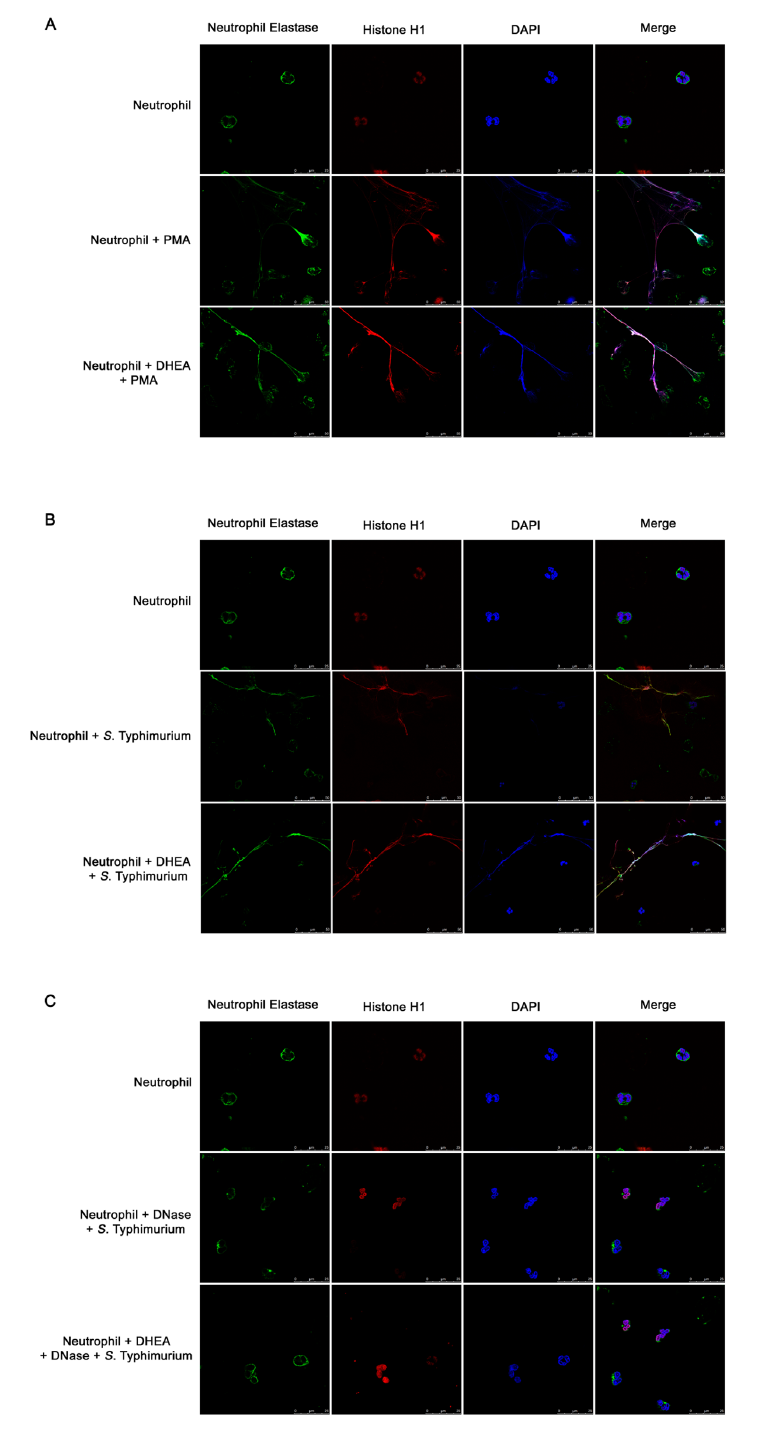
FIGURE 8 – S. Typhimurium and PMA promote NET formation by neutrophils. Neutrophils (7 x 104) were treated or not with 0.01 µM DHEA for 1 h, (A) and stimulated with PMA (0.162 µM) for 4 h or (B) S. Typhimurium (MOI=10). As a negative control the cells were treated with the enzyme DNaseI (100 U/mL) 30 min before the infection (C). The neutrophils were subjected to nuclear staining with DAPI (blue), for neutrophil elastase (green) and for histone H1 (red). The cells were analyzed with a confocal laser scanning microscope, and the co-localization of the markers shows the formation of NET. Magnification: 630